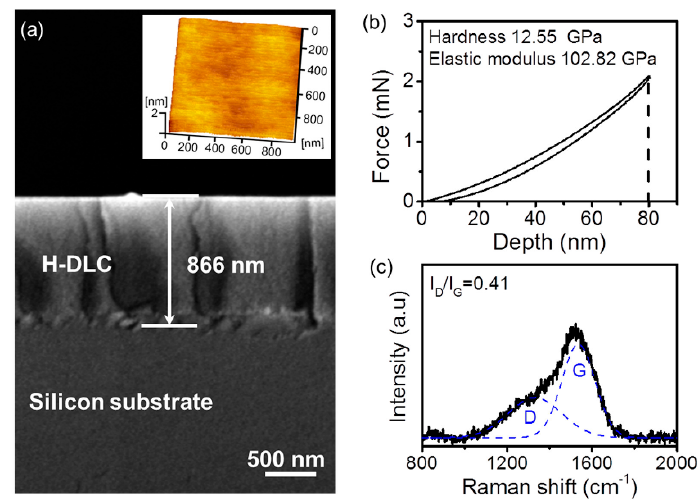
Figure 1. Properties of the hydrogenated diamond ‐ like carbon (H ‐ DLC) film used in the velocity ‐ dependent friction tests. ( a ) SEM image of a fractured cross ‐ section of the H ‐ DLC film. Inset shows the AFM image of the H ‐ DLC film with a RMS roughness of ~0.20 ± 0.02 nm. ( b ) Nanoindentation load − displacement curve of the H ‐ DLC film. ( c ) Raman spectra of the H ‐ DLC film.